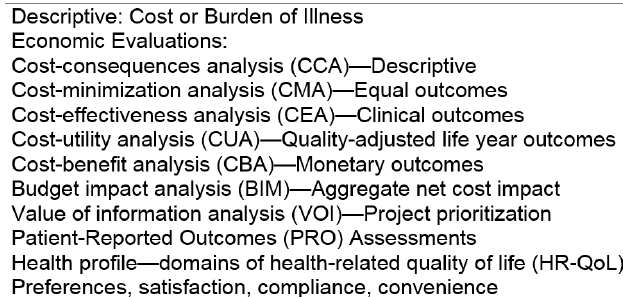
Figure 1. Types of health economics and outcomes research (HEOR) studies.